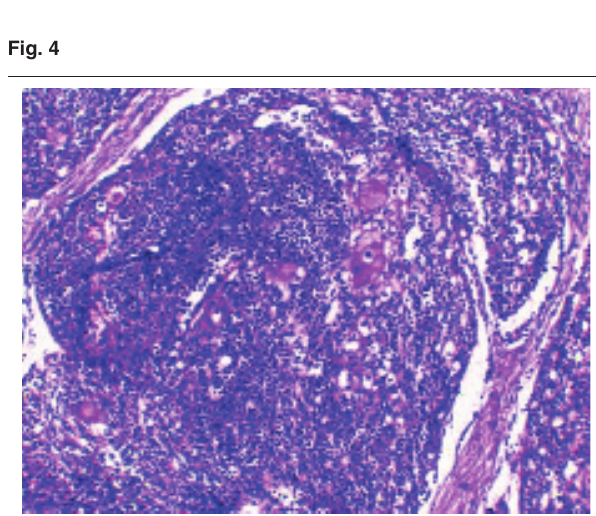
c (a–d) Thoracoscopic pictures of lobulated, whitish, and vascular mass originating from the costal pleura.